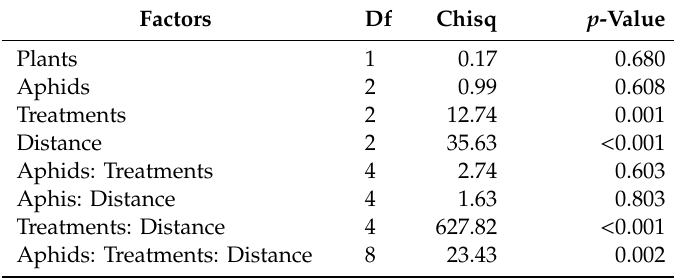
Table 1. Synthesis of analysis of the deviance (Anova) for fixed factors plants, aphids, treatment and distance and their interactions on aphid’s abundance on amaranth